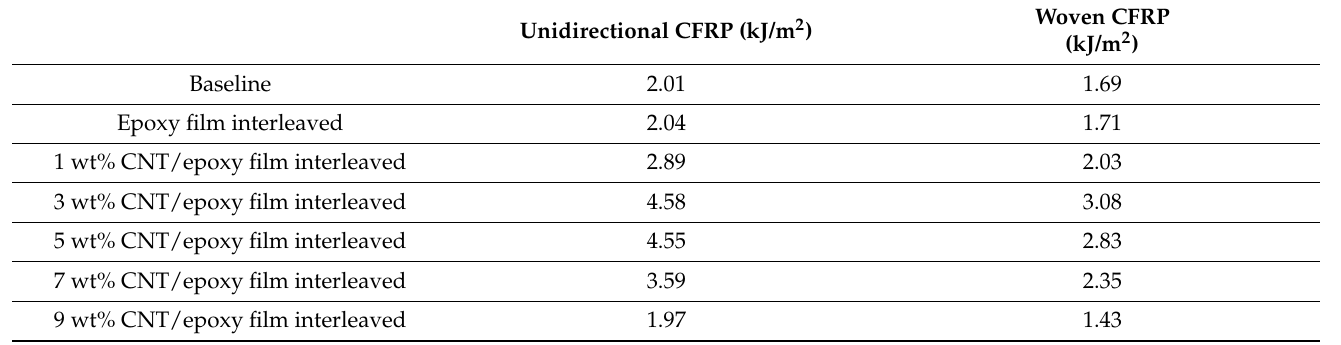
Table 2. Average mode II interlaminar fracture toughness ( G IIC )